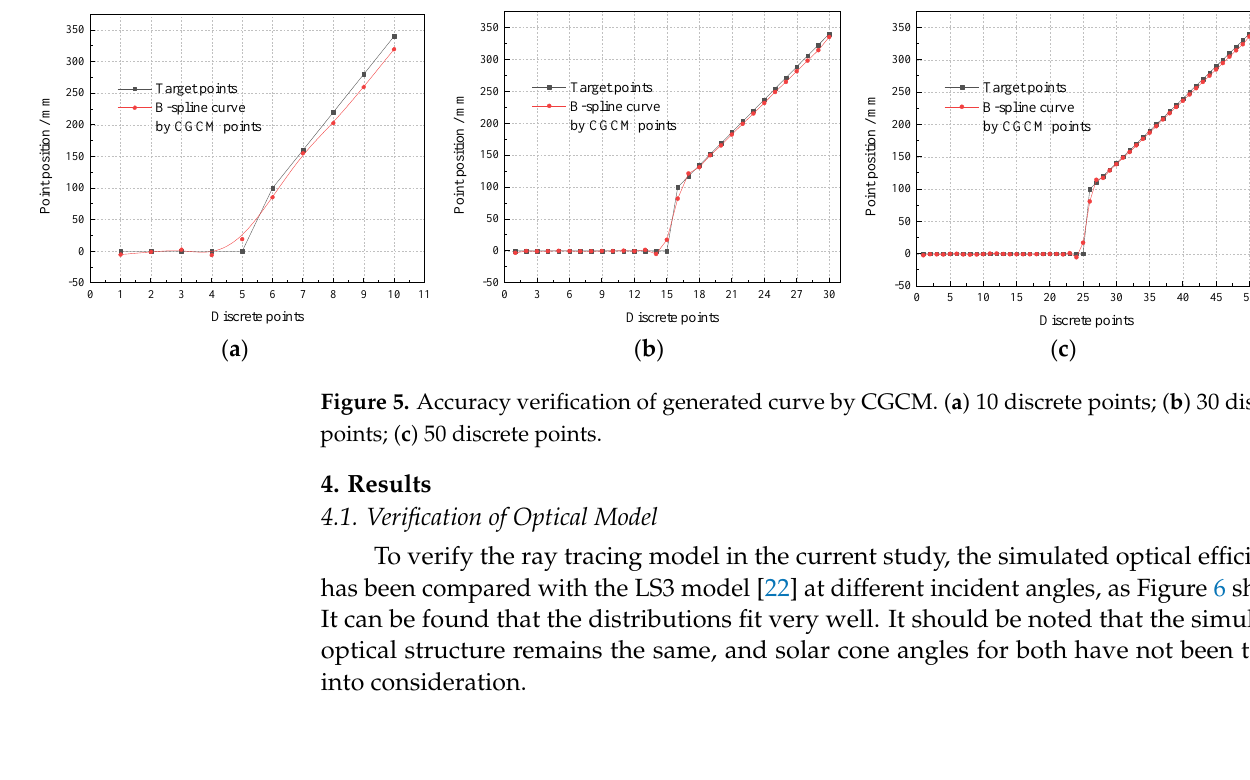
Figure 5. Accuracy verification of generated curve by CGCM. ( a ) 10 discrete points; ( b ) 30 discrete points; ( c ) 50 discrete points.